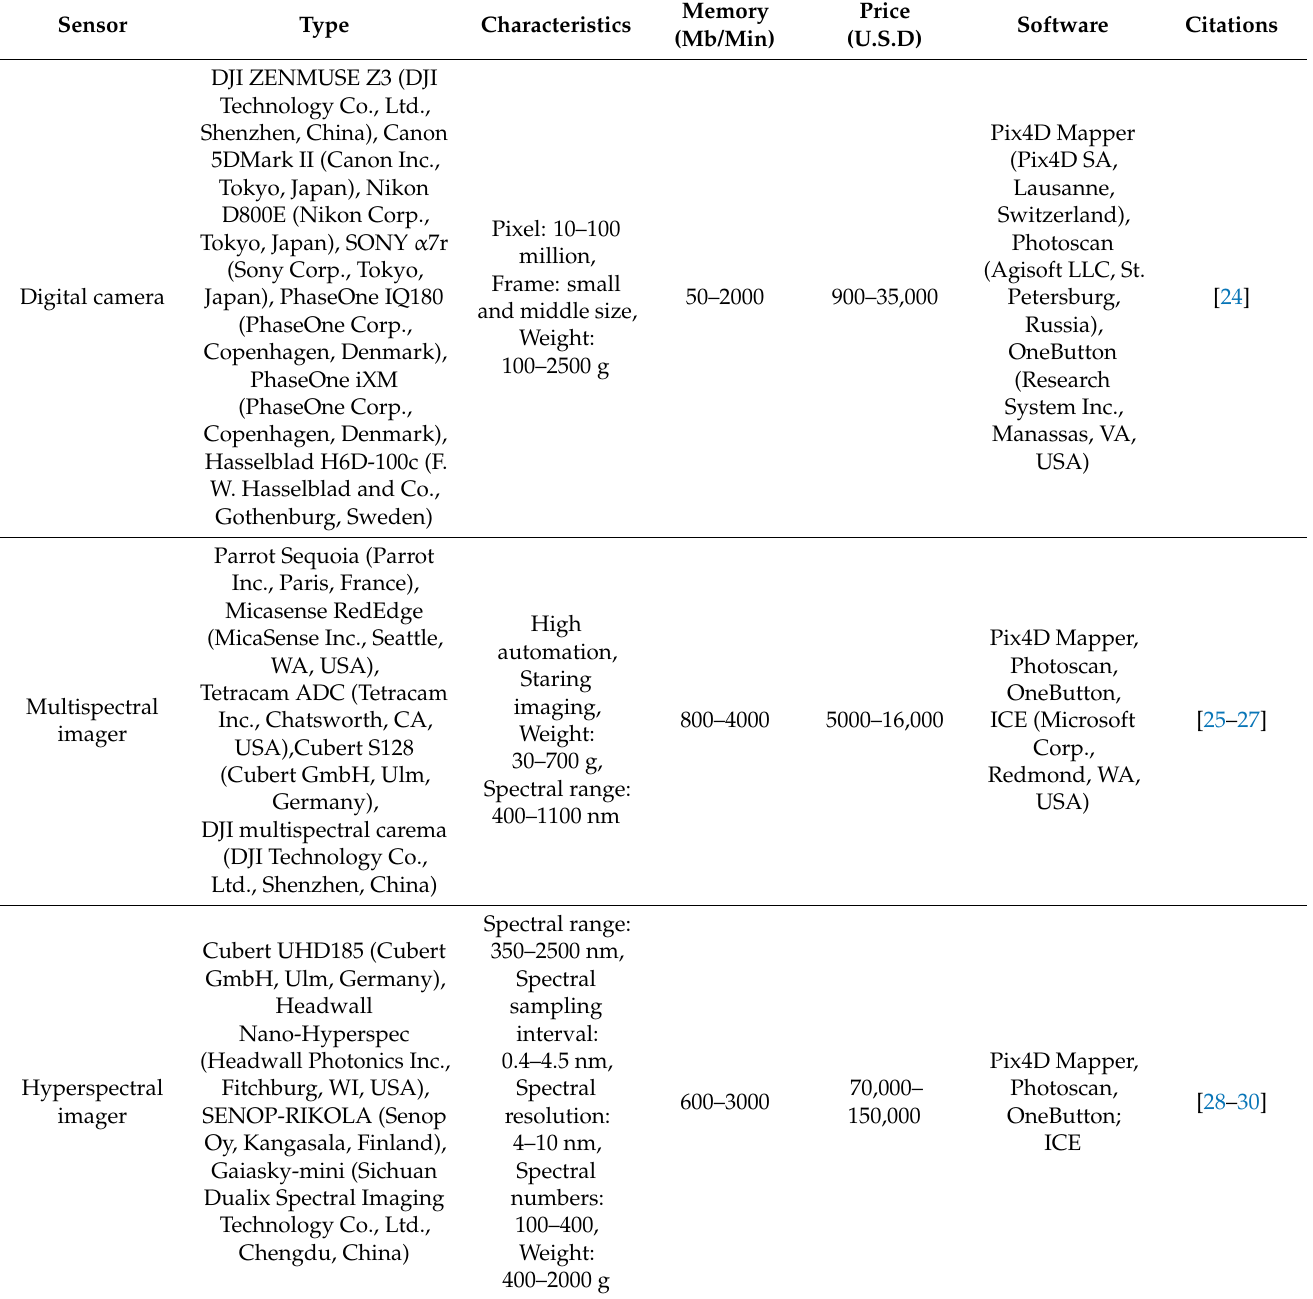
Table 3. Different types of sensors used in agricultural